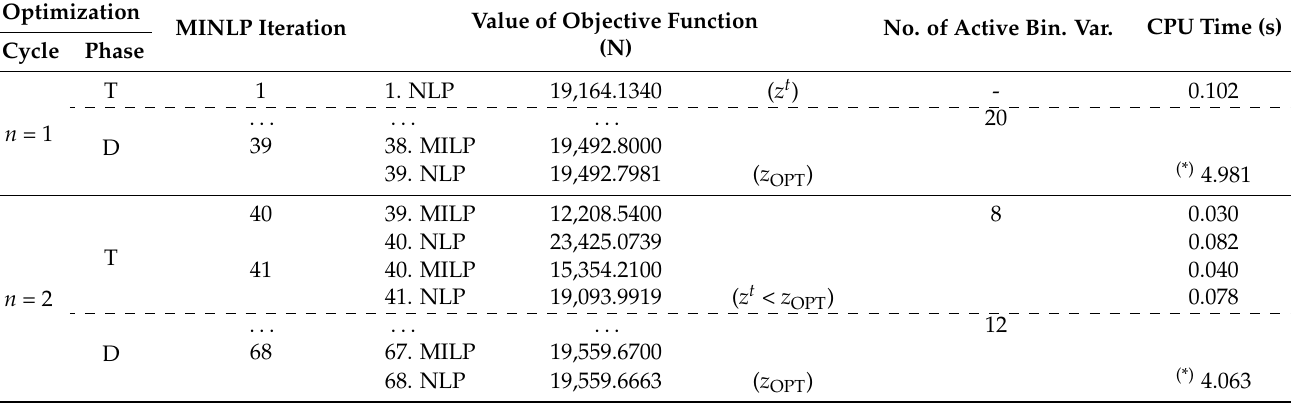
Table 2. Convergence of the Modified OA/ER algorithm and the STP strategy, example TC10a (topology optimization, without buckling